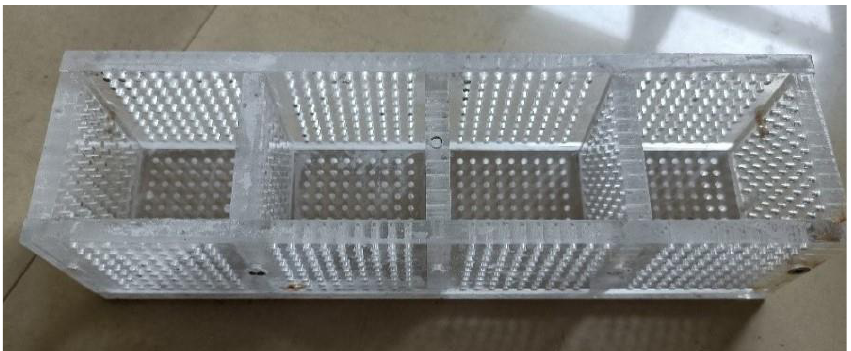
Figure 1. Organic glass molds with